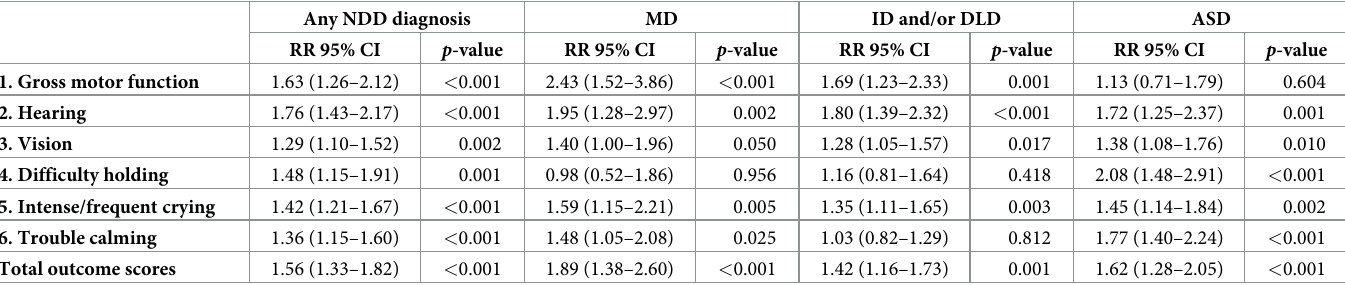
Table 7. Relative risk of a diagnosis of neurodevelopmental disorder at 3 years of age for each “developmental concern” item observed at 1 month of